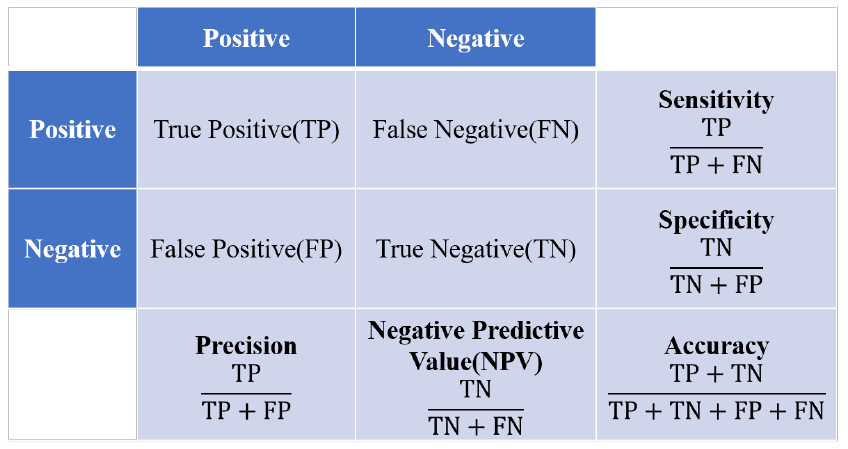
Figure 4. Confusion matrix and evaluation metrics.